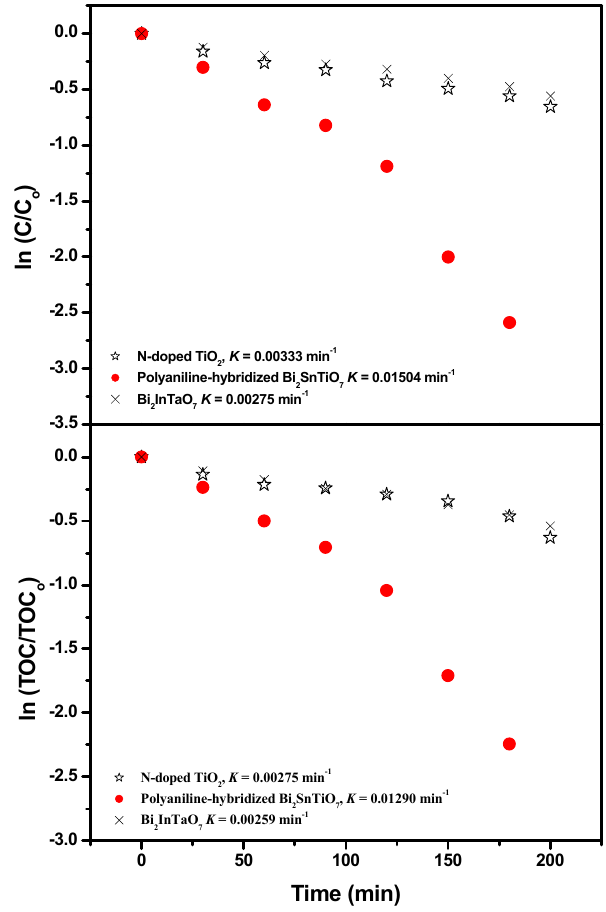
Figure 6. Observed first-order kinetic plots for the photocatalytic degradation of methylene blue with the polyaniline-hybridized Bi under visible light